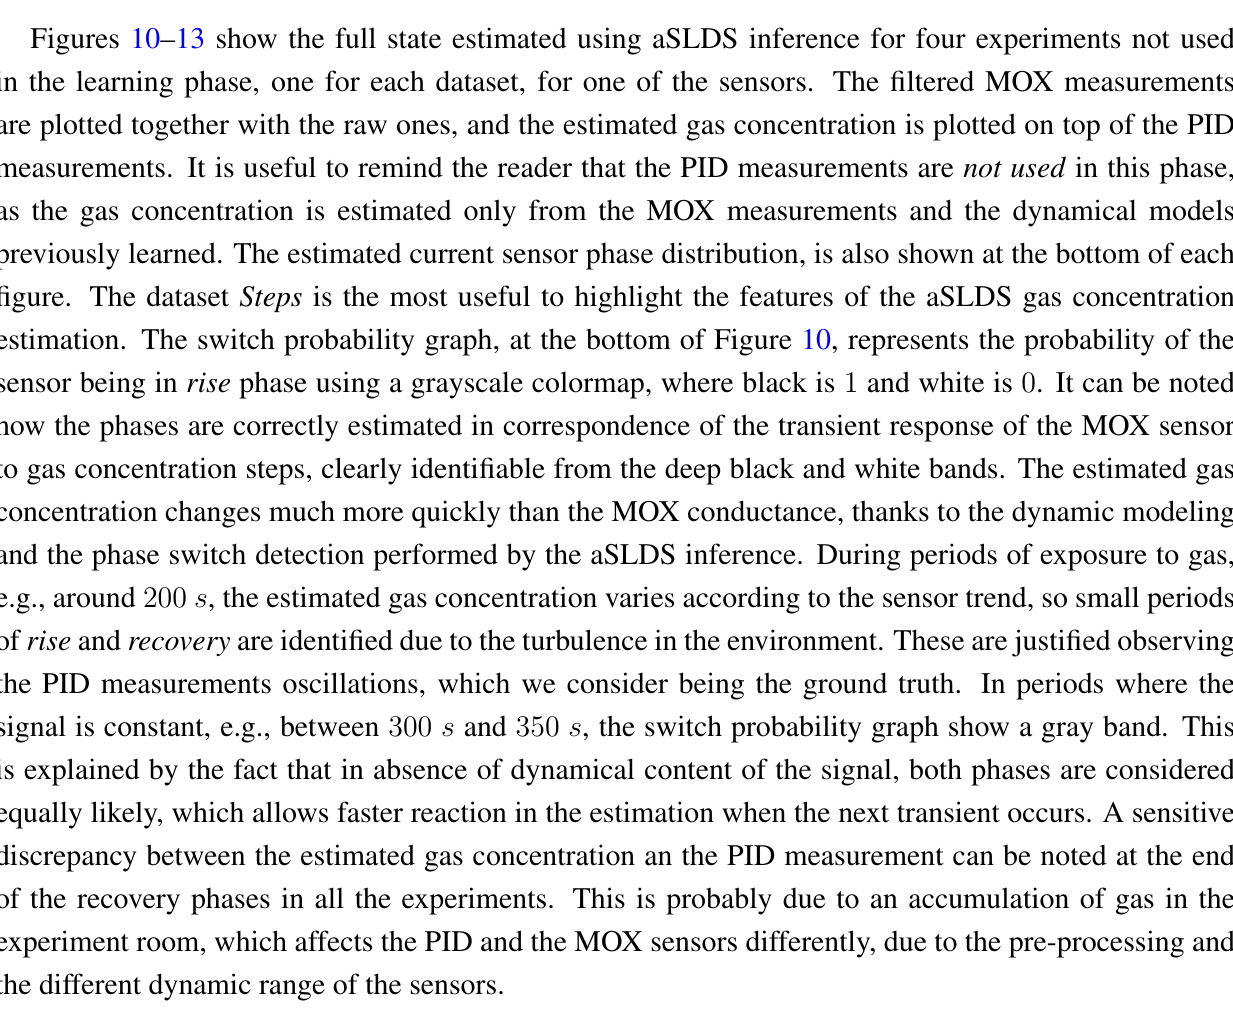
Figure 10. aSLDS inference results for an experiment of dataset Steps . ( Top ) MOX measurements, ( Middle ) Gas concentration, ( Bottom ) Sensor phase probability